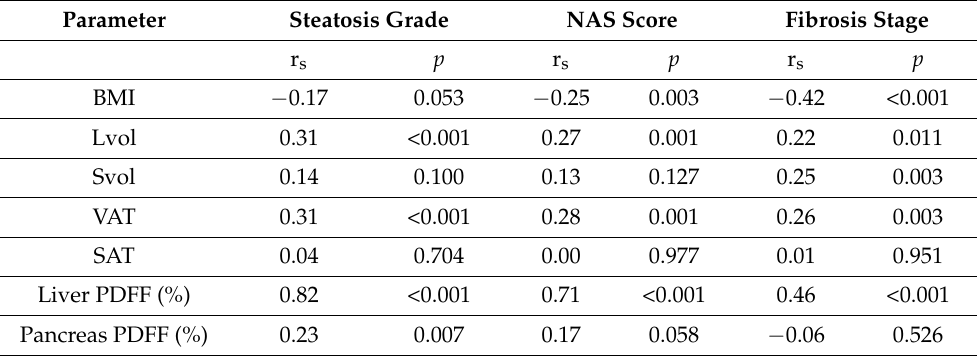
Table 4. Correlation coefficients among steatosis grade, NAS score, fibrosis stage and BMI, Lvol, Svol, VAT, SAT, liver and pancreas PDFF in the study cohort